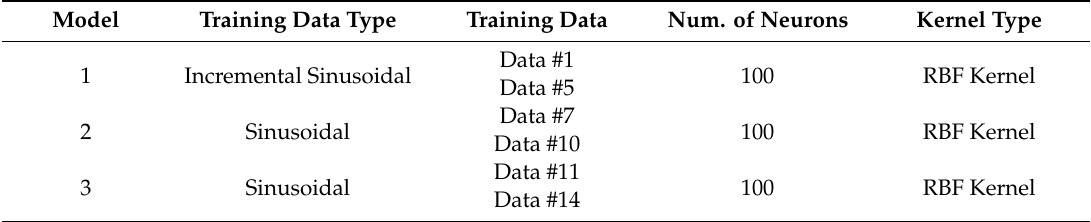
Table 2. LS-SVM model